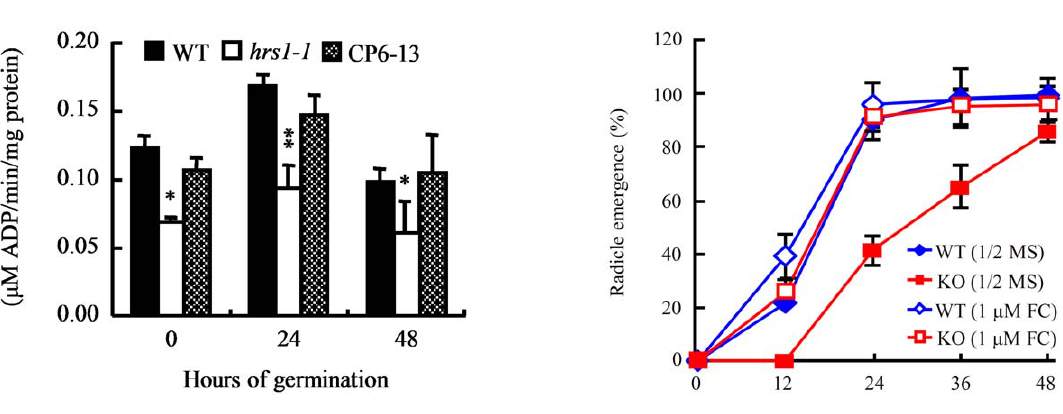
Figure 9. Analysis of plasmalemma H + -ATPase activity during the germination of wild type control, hrs1-1 and complemen- tation line. The seeds of wild type (WT) control, hrs1-1 and complementation line CP6-13 were cold stratified for 48 h, followed by germination on 1/2 MS medium at 23 u C. The levels of H + -ATPase activity (means 6 SD, each calculated with the results of triplicate samples) were determined using plasma membrane enrich fractions prepared from the seed samples taken at the indicated time points. The data shown are typical of three independent experiments. The results obtained with the additional CP lines (CP19-1 and CP23-3) were highly similar to those determined for CP6-13 during the experiments. Single and double asterisks indicate statistical significance from WT control at P # 0.05 and 0.01, respectively.